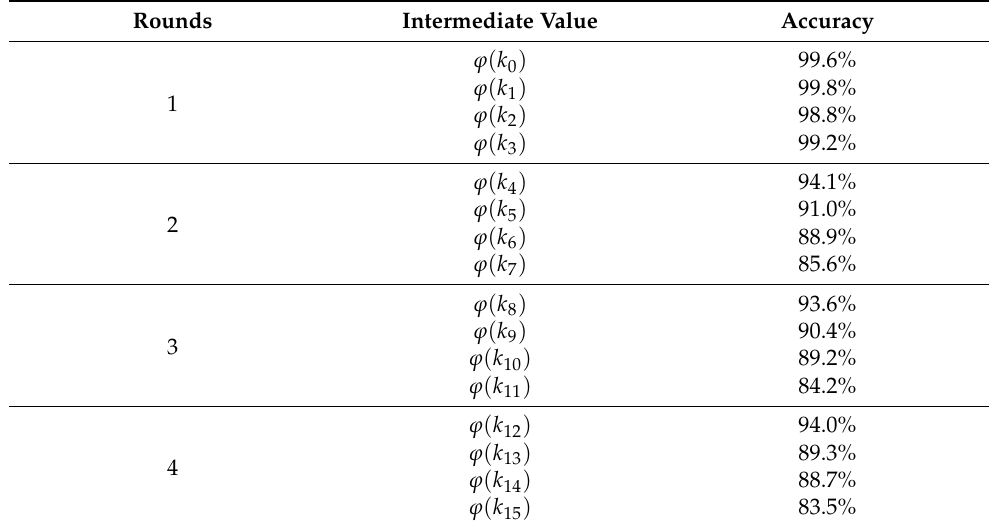
Table 2. The attack results of recovering the full key based on intermediate value.